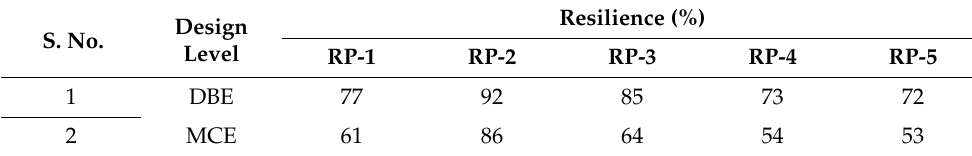
Table 14. Building resilience with respect to each design level corresponding to Case III. S. No.